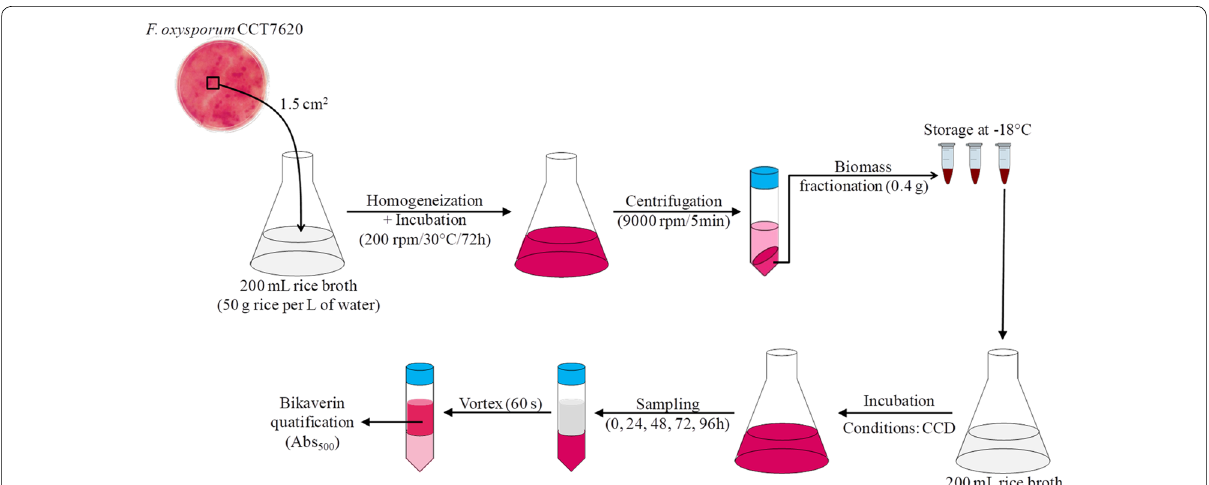
Fig. 2 Scheme of inoculum preparation, fermentation for each assay, extraction and analysis of bikaverin